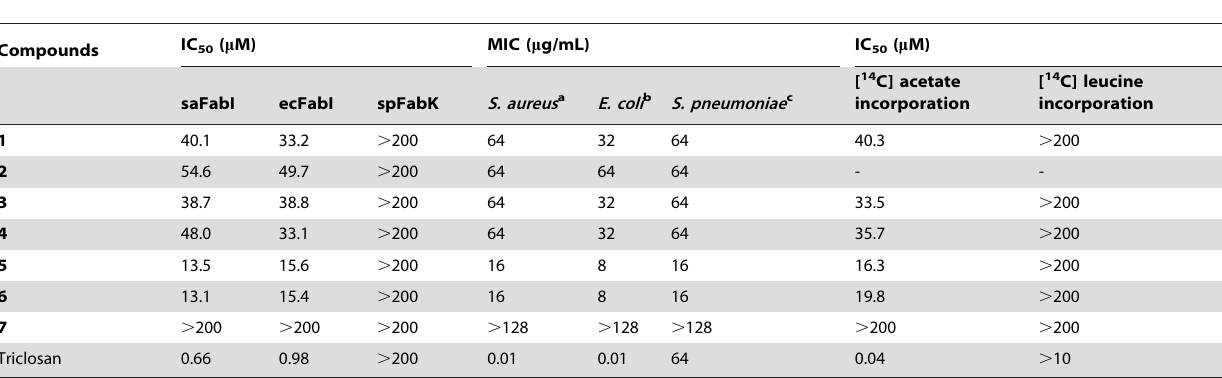
Table 1. Comparison of the inhibitory effects of meleagrin ( 1 ) and its derivatives against Staphylococcus aureus and E. coli FabI, bacterial growth, and [ 14 C] acetate and [ 14 C] leucine incorporation into membrane fatty acids.